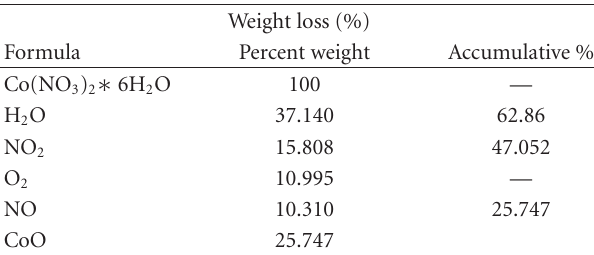
Figure 6: Energy formation Δ G analysis of acetone decomposition. Table 1: Decomposition of cobalt nitrate (from 25 to 400 ◦ C).